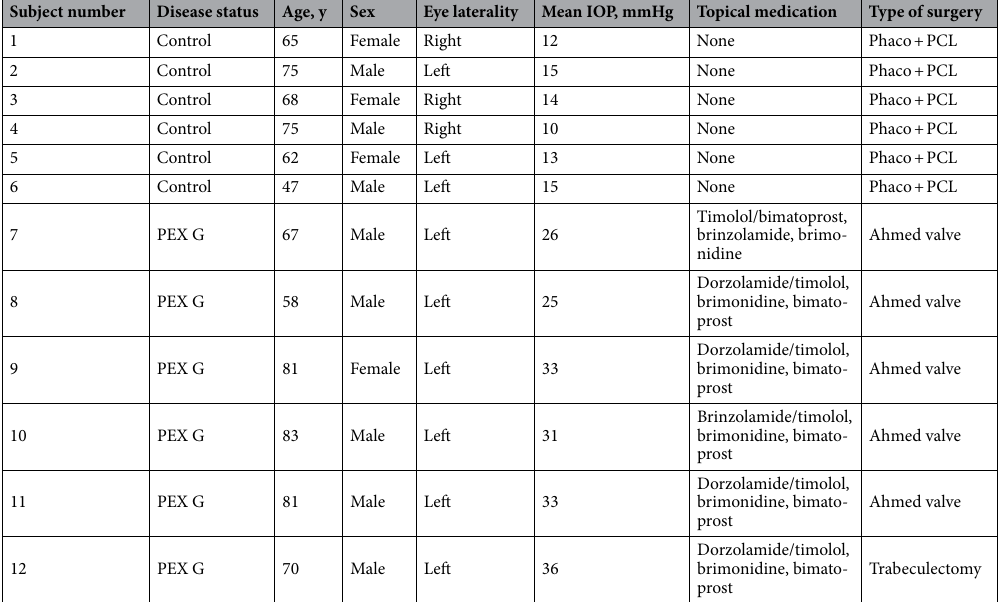
Table 1. Baseline characteristics and demographics of subjects. IOP intraocular pressure, NTG normal tension glaucoma, PEX pseudoexfoliation, G glaucoma, Phaco + PCL phacoemulsification and posterior intraocularlens insertion, Ahmed valve Ahmed valve